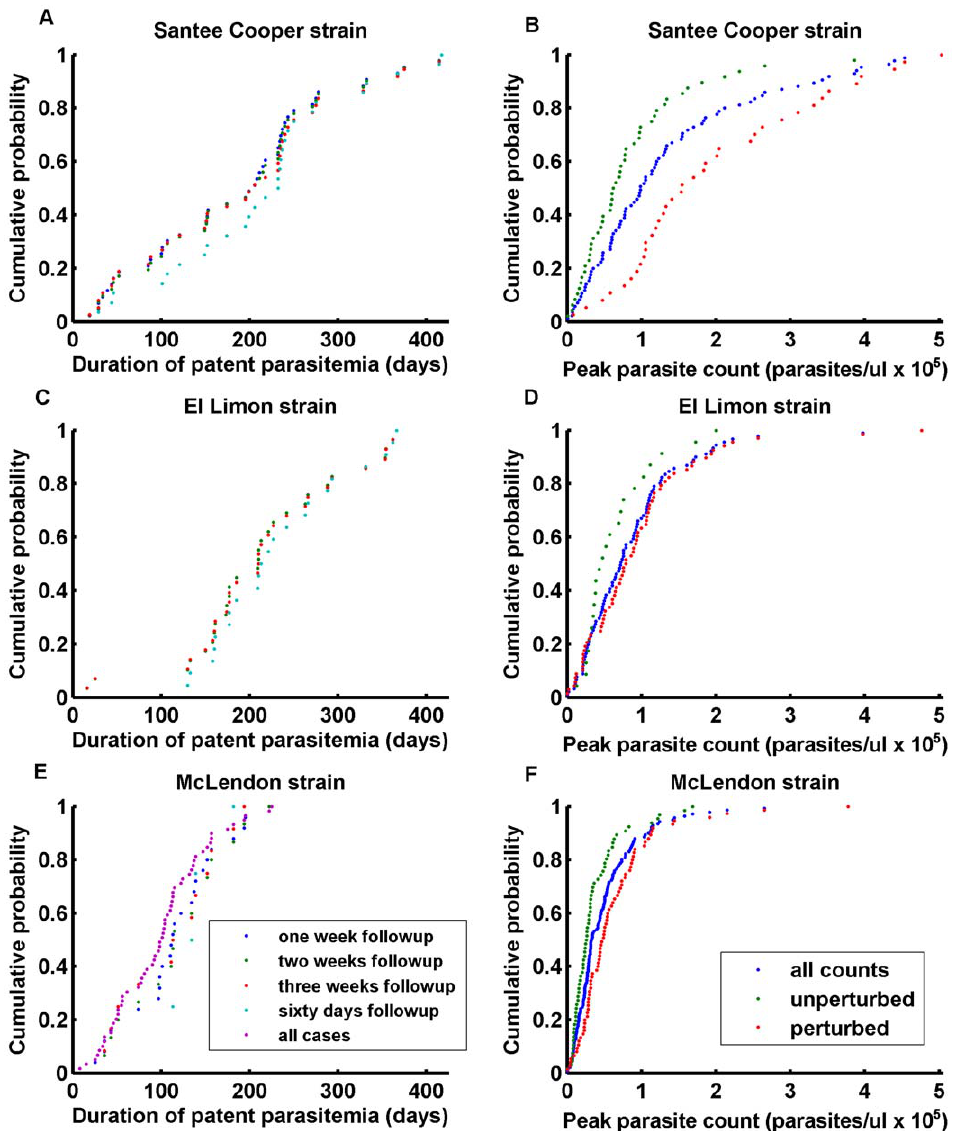
Figure 1. Measured durations and peak parasite counts in the malariatherapy data. Durations (A,C,E) and peak parasite counts (B,D,F) from malariatherapy dataset for the Santee Cooper, El Limon, and McLendon strains. Inclusion criteria are described for durations and peak parasite counts. For the latter, ‘‘unperturbed’’ implies no drug treatment before the fifth day after the measured peak. Even perturbed cases (light blue) are included, since these cases requiring drug treatment represent possible high-parasitemia outcomes. doi:10.1371/journal.pone.0044950.g001 plot area into values for kill rates that diminish the parasite responses, either merozoite-blocking immunity, or immunity to population below the replacement level allowed by merozoite shared minor epitopes reduces the overall parasite density immunity (right and upwards of each curve) and those for which envelope as immunity develops and extends the duration of the parasite will continue to proliferate until antibody levels passage through the antigenic repertoire, indicated by the major increase (left and downward). The x-axis shows the value of the drop in parasite density. Extending much beyond 200 days allows antibody kill rate C antibody ; the y-axis, the value of non-specific reuse of antigenic variants and recrudescence with reduced parasite density. Note that the lower shared immunity results in antigenicity c minormod . Known characteristics of infection dy- higher parasite densities and a more deterministic infection, but namics place firm constraints on the covariation of model that reduced parasite densities and extended durations result in parameters, thereby reducing the effective degrees of freedom. much more infection variation, even with fixed parameters. The Higher values of C merozoite shift each curve left, which may also highest shared immunity corresponds to the broadest distribution be the effect of potential vaccines that reduce the success of infection. probability of merozoite invasion [34]. Each curve in panel c) corresponds to a set of fixed antibody levels for merozoite inhibition C merozoite = 0.5. They divide the